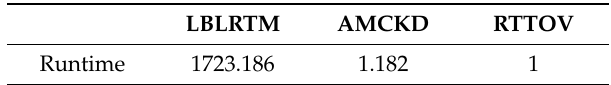
Table 2. Comparison of the runtime of LBLRTM, AMCKD, and